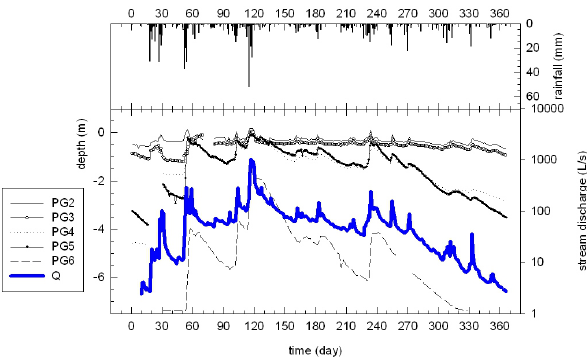
Fig. 2. Daily precipitation, discharge and water table depth in the five wells for the water year 1999–2000; the first day is 1 September 1999 (Adapted from Molenat et al., 2005).